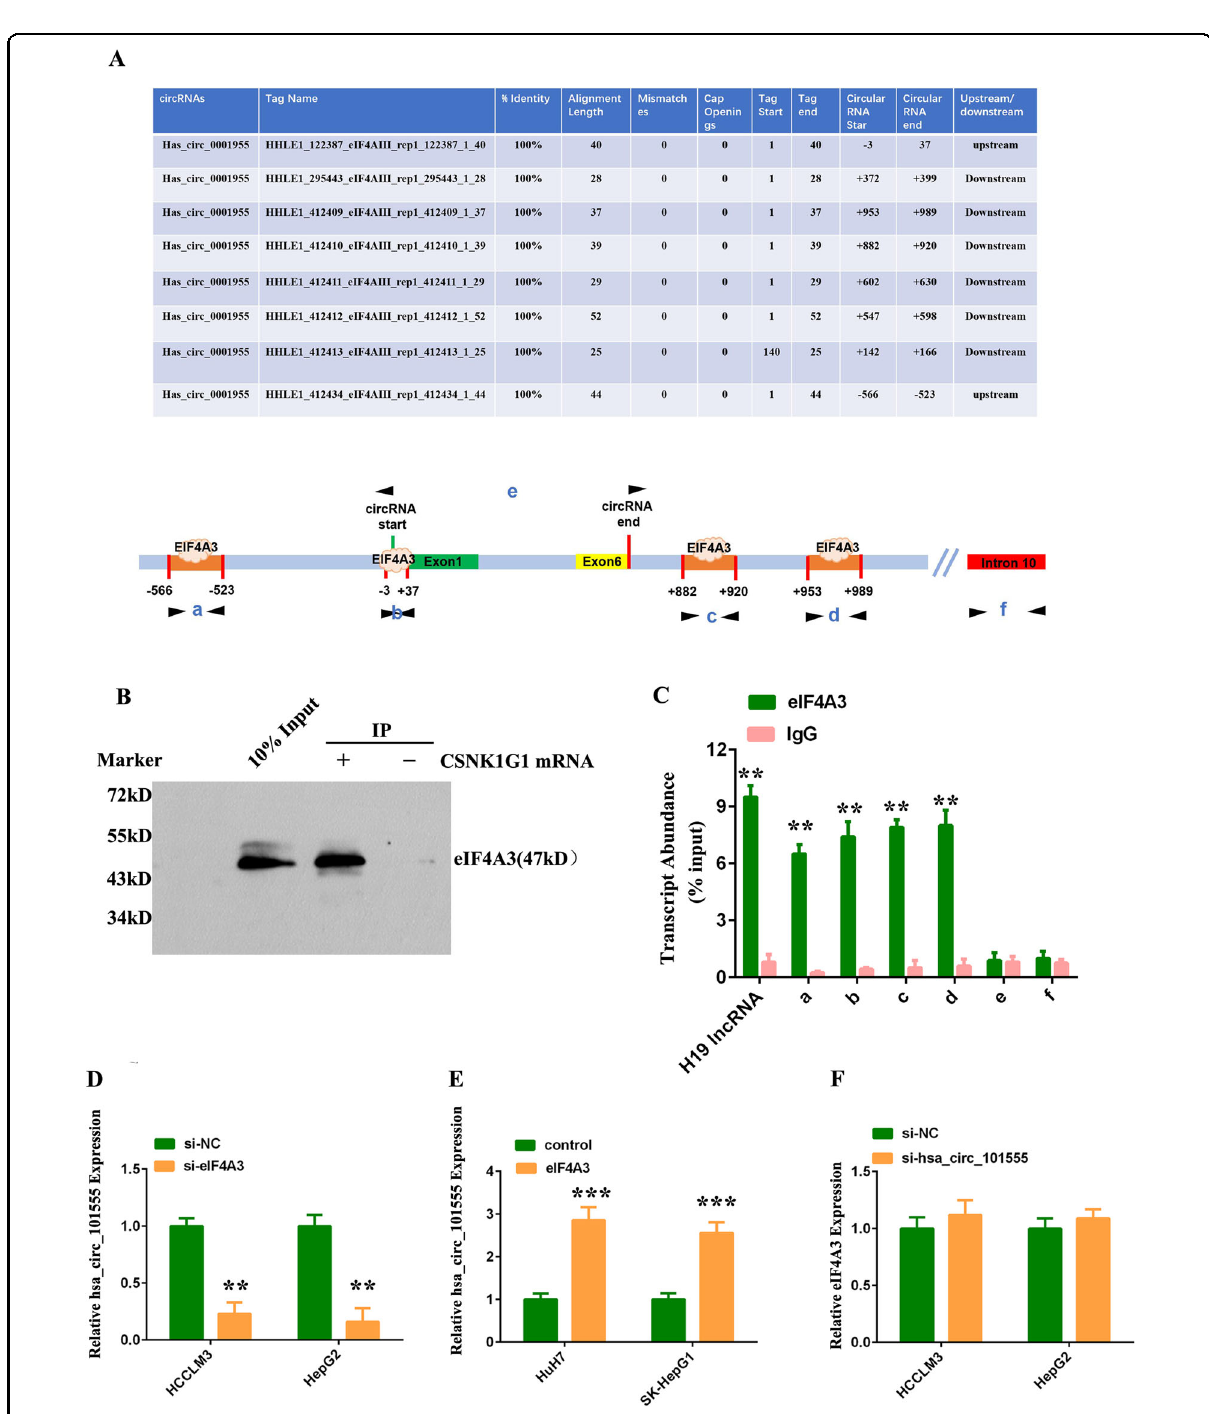
Fig. 4 The RNA-binding protein EIF4A3 regulates hsa_circ_101555 expression. A Binding sites for EIF4A3 on the CSNK1G1 mRNA transcript, upstream or downstream of hsa_circ_101555, obtained from Circular RNA Interactome. B Pull-down assay con fi rms the enrichment of EIF4A3 protein in CSNK1G1 mRNA pull-down. C Quantitative real-time PCR following EIF4A3-RIP assay con fi rms the binding of EIF4A3 on the predicted binding region (a, b, c, and d) of CSNK1G1 mRNA. H19, a known interacting long noncoding RNA (lncRNA) with EIF4A3, served as the positive control. The intron 10 of CSNK1G1 mRNA was used as a negative control. D HCCLM3 and HepG2 cells transfected with control or siRNA targeted eIF4A3; hsa_circ_101555 expression detected by qRT-PCR. E HCCLM3 and HepG2 cells transfected with control or eIF4A3 overexpression plasmids; hsa_circ_101555 expression measured by qRT-PCR. F HCCLM3 and HepG2 cells transfected with control or siRNA targeted hsa_circ_101555; eIF4A3 expression detected by